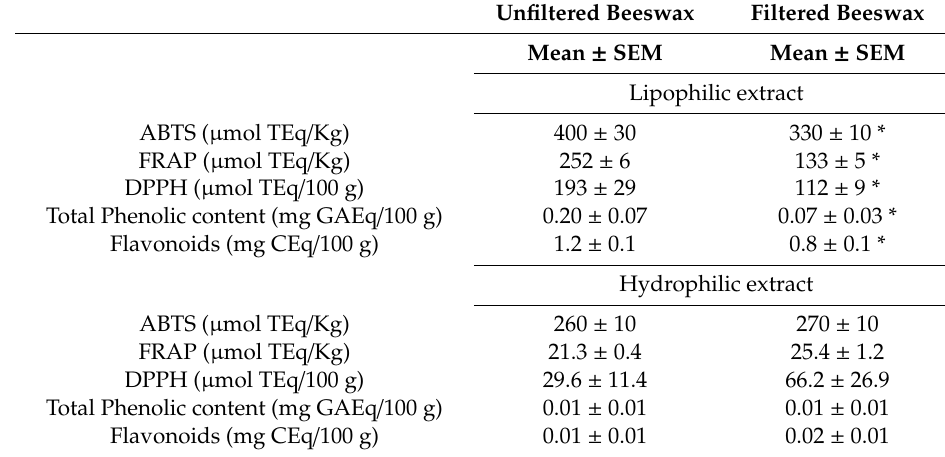
Table 5. Total antioxidant capacity, polyphenol and flavonoid content in unfiltered and filtered beeswax samples in the lipophilic and hydrophilic extracts (n =